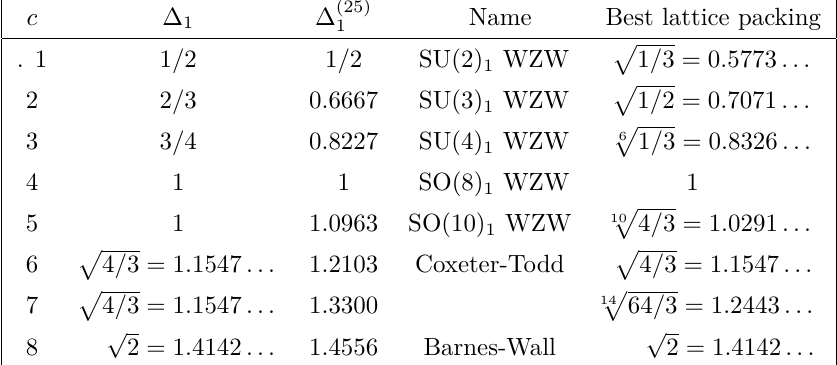
Table 1 . Putatively optimal Narain compactifications, along with the spinning modular bootstrap bound and the best lattice sphere packing known in R 2 c (without the Narain